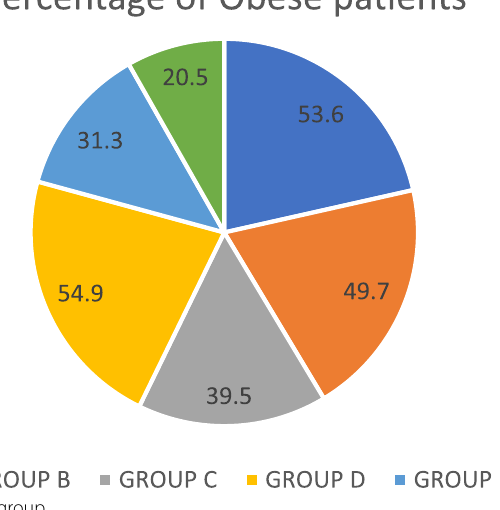
Fig. 1 Percentage of obese patients in each group